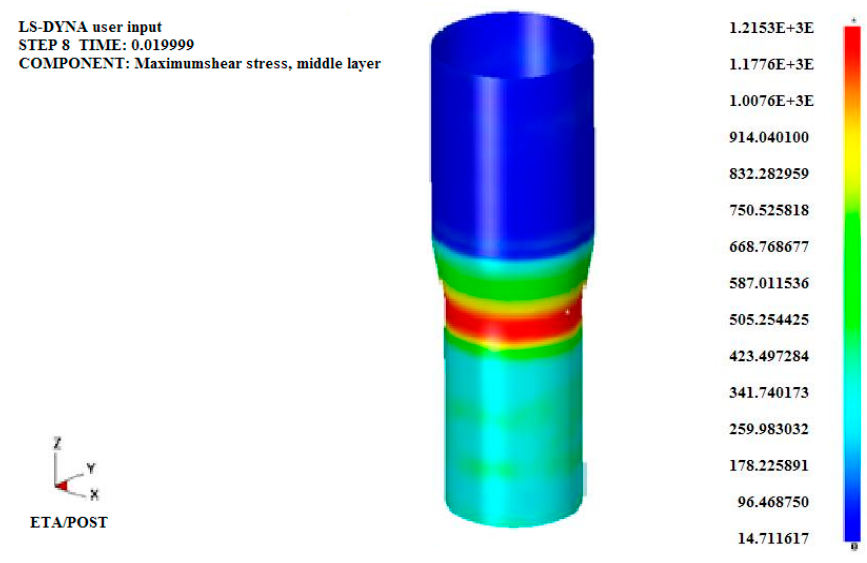
Figure 15. Stress in the formed material after the third draw σ = 1 215 MPa.